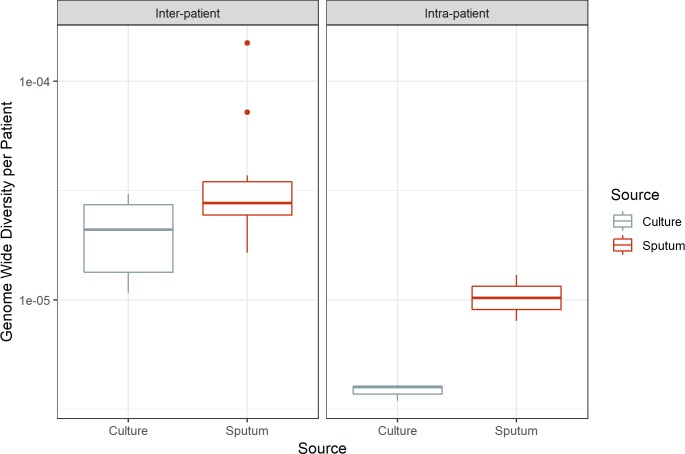
Genome-wide diversity in sputum and culture. Average genome-wide nucleotide diversity (π) in sputum and culture samples. Sputum and culture pictured in red and gray, respectively. Left box, inter-patient samples; right box, intra-patient samples. Medians 2.77e-05 and 2.10e-05, 1.02e-05 and 3.98e-06 for sputum and culture in inter-patient and intra-patient samples, respectively.